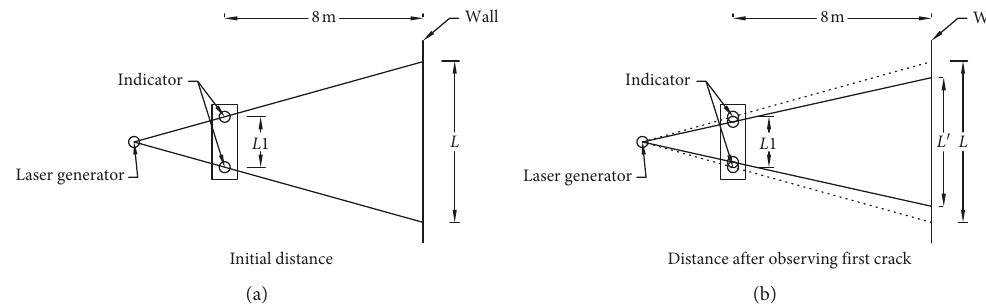
Figure 6: Tensile strain measurement. (a) Initial distance. (b) Distance after observing first crack.